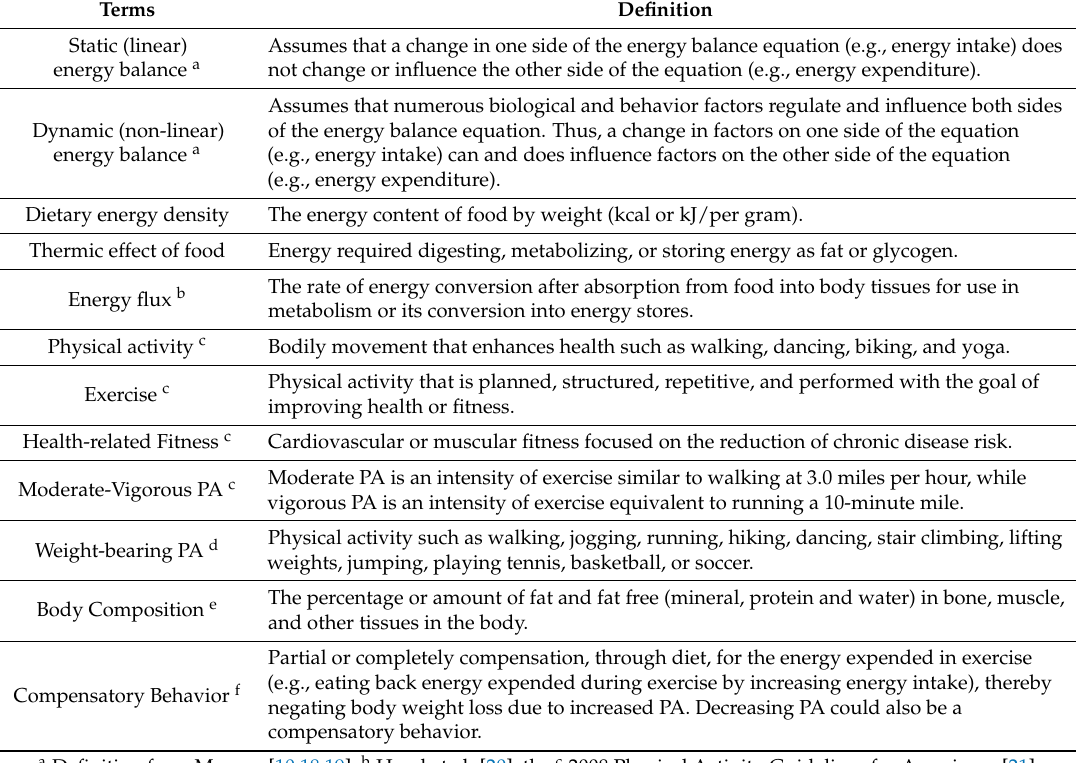
Table 1. Definition of terms frequently used when discussing diet and physical activity (PA) for weight